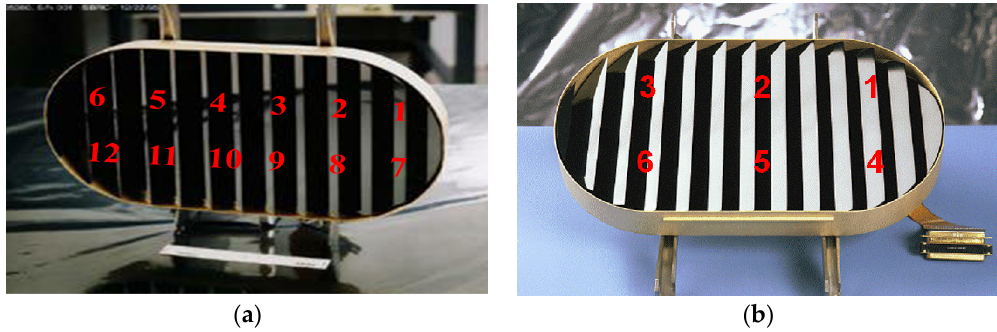
Figure 2. V-grooved BlackBody controlled using various thermistors ( a ) MODIS; ( b ) VIIRS [6].